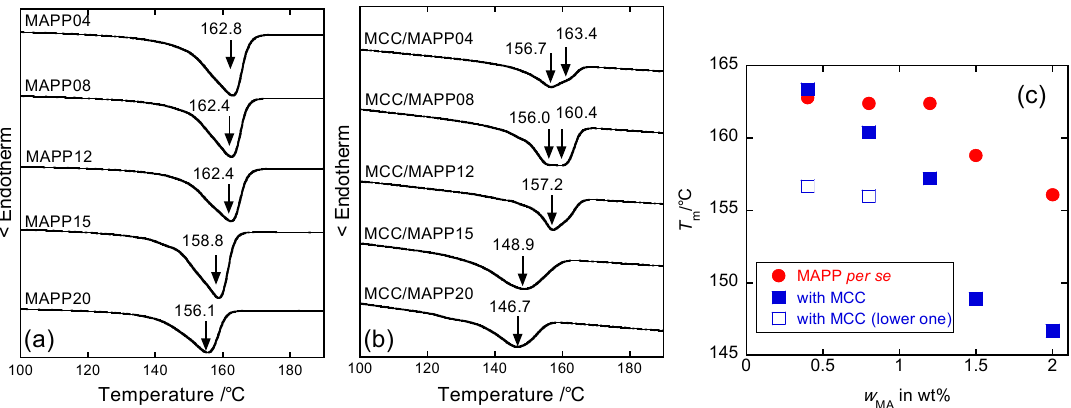
Figure 9. DSC thermograms (second heating scan): ( a ) plain MAPP samples with various w MA values, and ( b ) their binary composites with MCC. Panel ( c ) plots T m against the added w MA of MAPP. Reprinted from Ref. [33]. Copyright Elsevier Ltd. (2019).